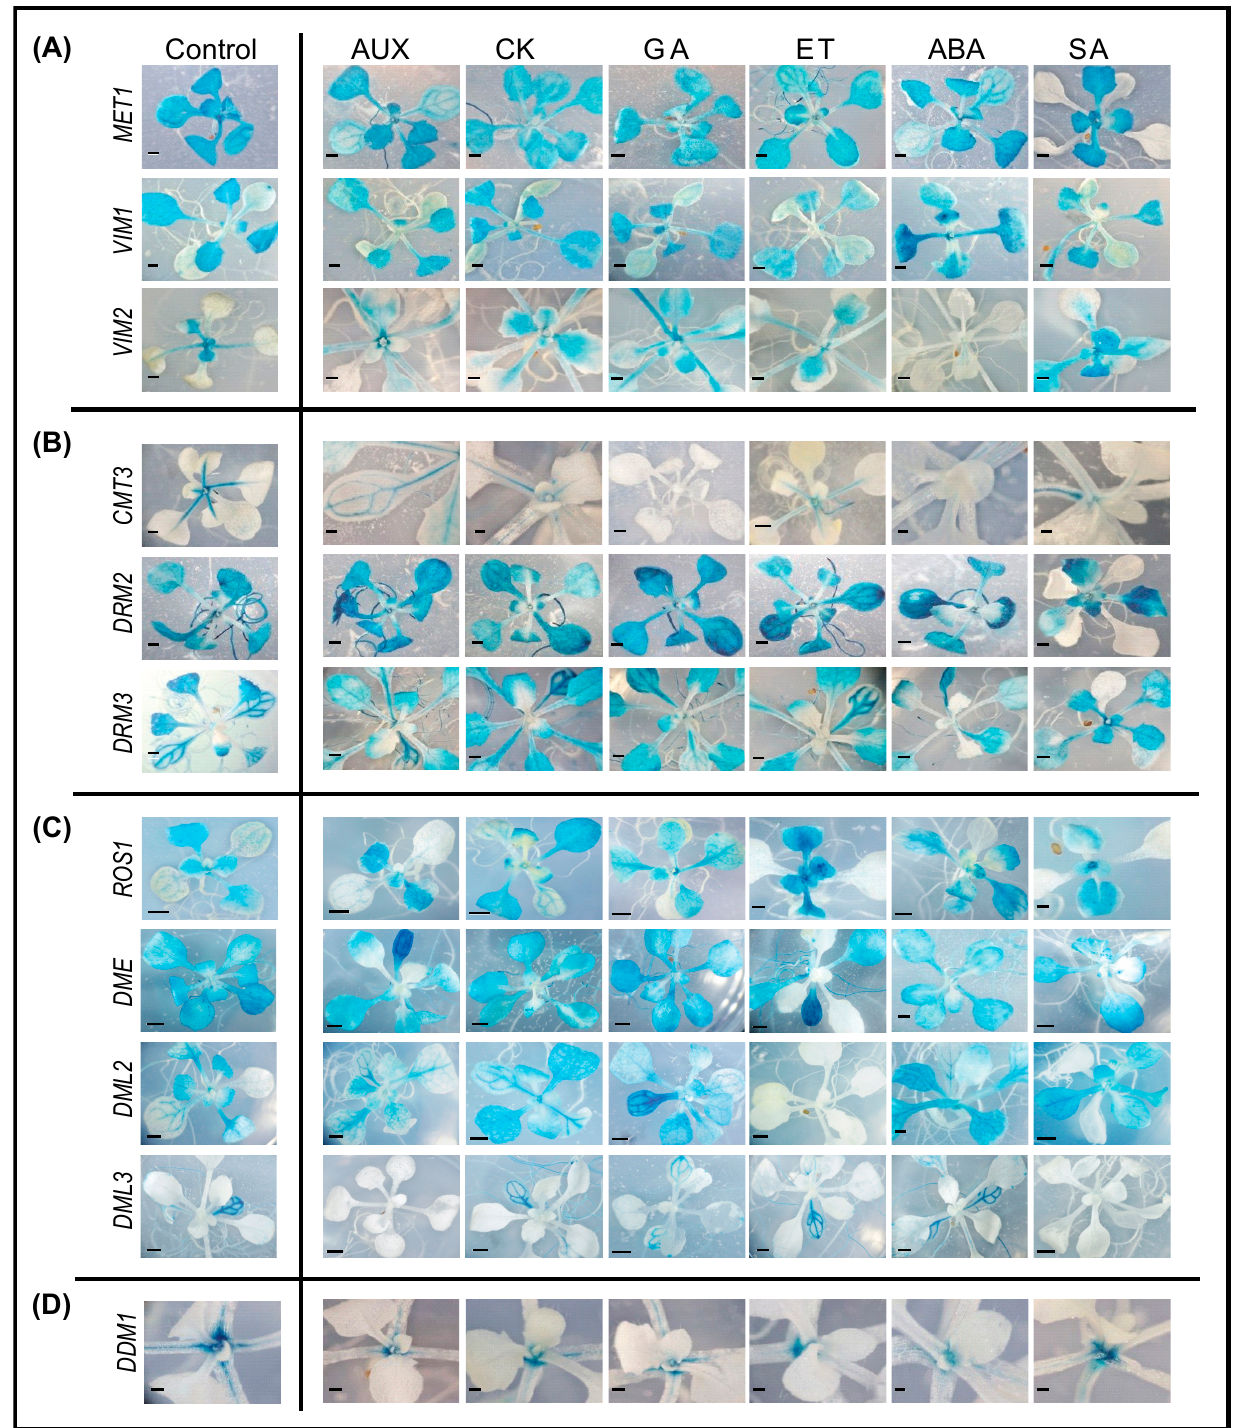
Figure 7. Promoter activity of DNA methylation and demethylation-related genes in two-week-old shoots in response to phytohormone treatments. A–C: Histochemical localization of GUS activity directed by promoters of the CG methylation- related genes MET1 , VIM1 , and VIM2 ( A ), the non-CG and RdDM-related methyltransferases CMT3 , DRM2 , and DRM3 ( B ), and the demethylases ROS1 , DME , DML2 , and DML3 ( C ), and DDM1 ( D ) in two-week-old shoots in response to exogenous application of auxin (AUX), cytokinin (CK), gibberellic acid (GA), ethylene (ET), abscisic acid (ABA), and salicylic acid (SA). Scale bar = 5 mm.